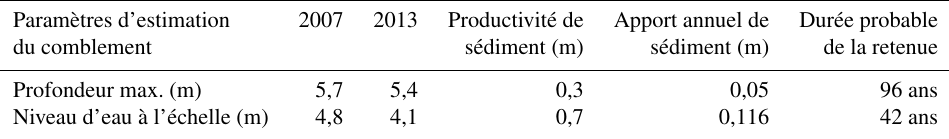
Tableau 3. Niveau de comblement et durée de fonctionnement de la retenue. Paramètres d’estimation